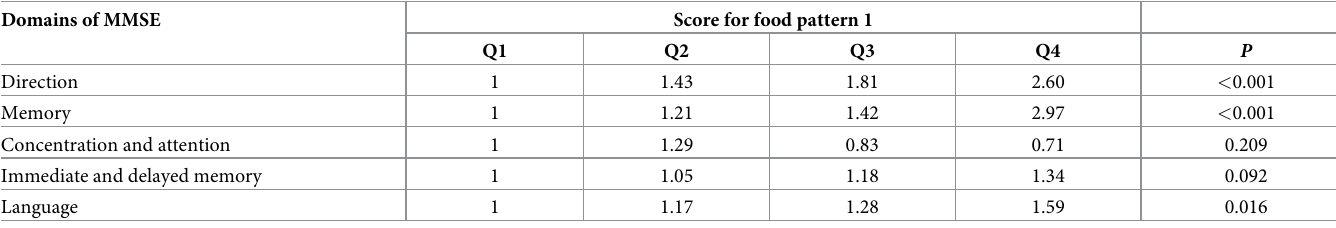
The data in the table represent standardized partial regression coefficients by multivariate linear regression